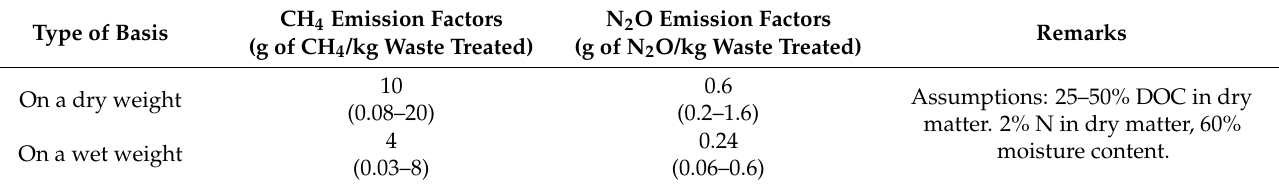
Table 2. Default emission factors for CH 4 and N 2 O emissions from composting process [14]. CH 4 Emission Type of Basis